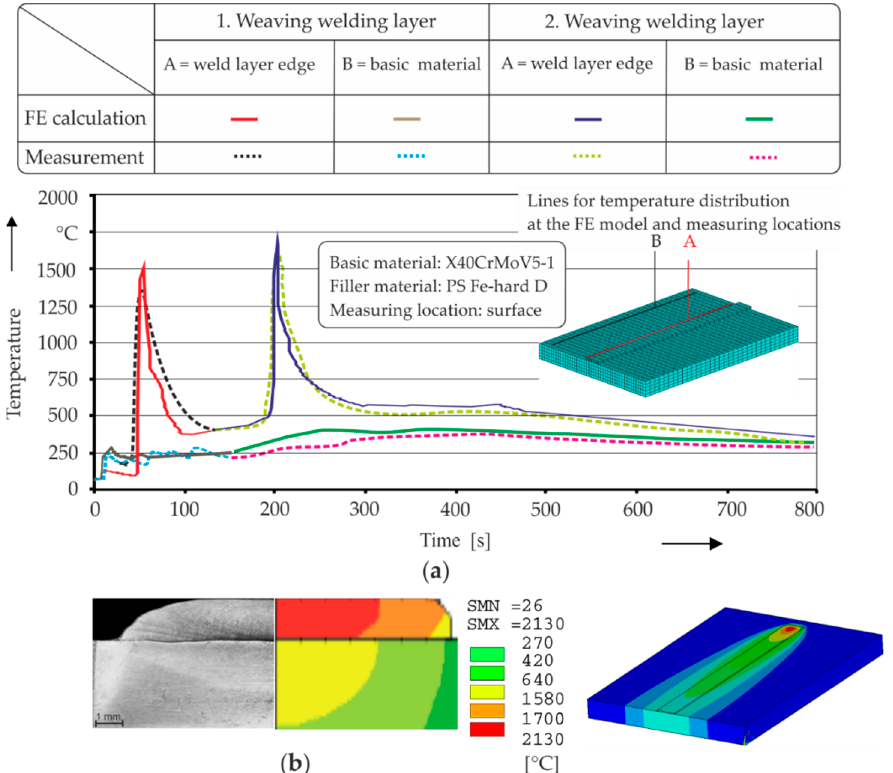
Figure 8. Comparison between calculated and measured values: ( a ) comparison—temperature and ( b ) comparison—layer geometry by weaving thermal deposition.